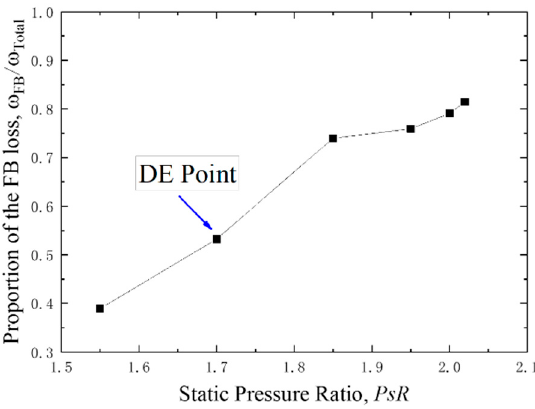
Figure 5. The proportion of the FB loss to the total loss at inlet Mach number 1.2.